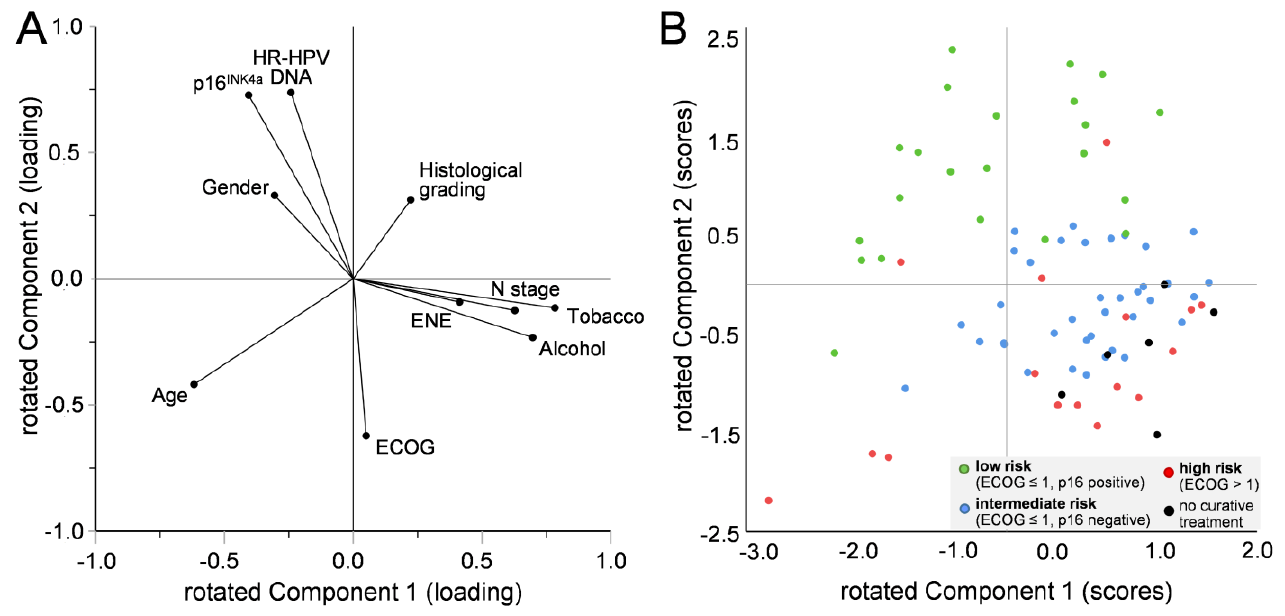
Figure 3. Principal component analysis (PCA) of tumor characteristics and lifestyle/patient-related risk factors in CUP HNSCC and distribution of cases according to the resulting two main components (components 1 and 2). ( A ): Loading plot of components 1 and 2 using the indicated variables (further details see text and Table 1). ( B ): Distribution of all cases with CUP HNSCC without missing data ( n = 81) according to the resulting main component scores in comparison to risk groups (green, red, and blue) predicted by recursive partitioning (RPA) and non-curative treatment (black).